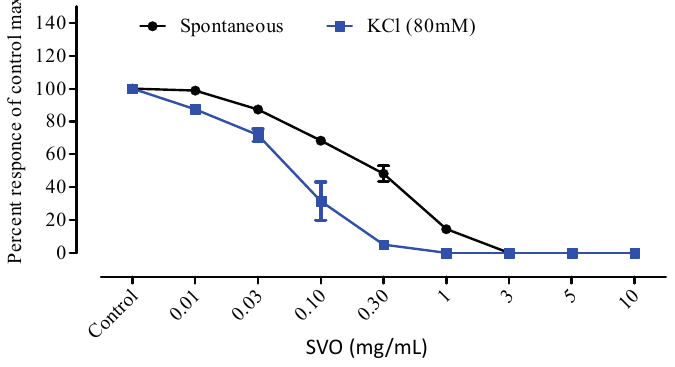
Figure 1. Dose response curve of Skimmia laureola essential oil (SVO) on isolated rabbit’s jejunum preparations. All values are the mean ± SEM, n = 5.